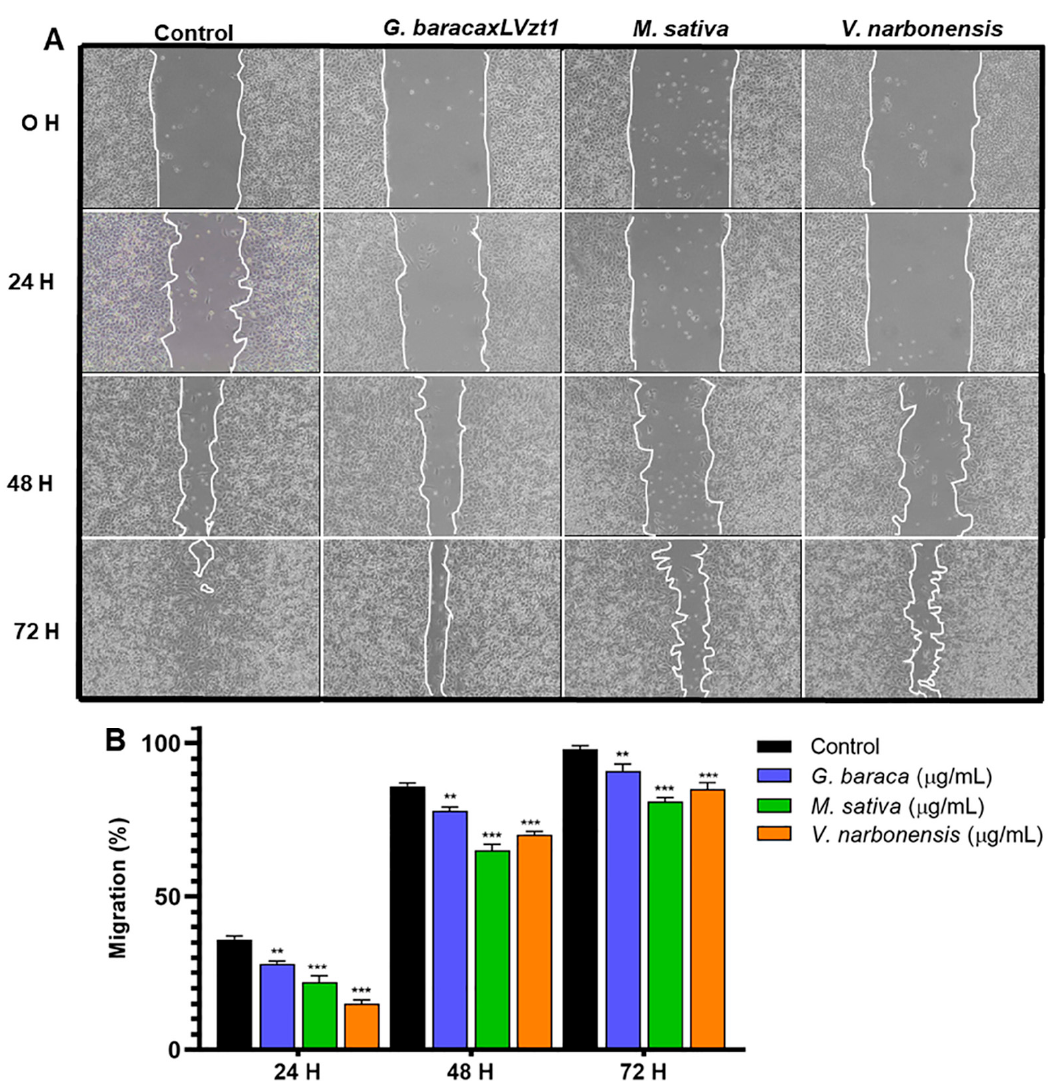
Figure 2. Analysis of the migration inhibitory capacity. ( A ) Representative images of the cell migration of the T84 line (0, 24, 48, 72 h) after exposure to a non-cytotoxic dose (IC15) of the protein hydrolysate from V. faba line Baraca × LVzt1 (germinated), M. sativa and V. narbonensis . ( B ) Graphical representation of the percentage of the migration of T84 tumor cells. Data are reported as mean ± SD with experiments performed in triplicate. Significant values are denoted by (**) p ≤ 0.01 highly significant, (***), p ≤ 0.001 very highly significant.